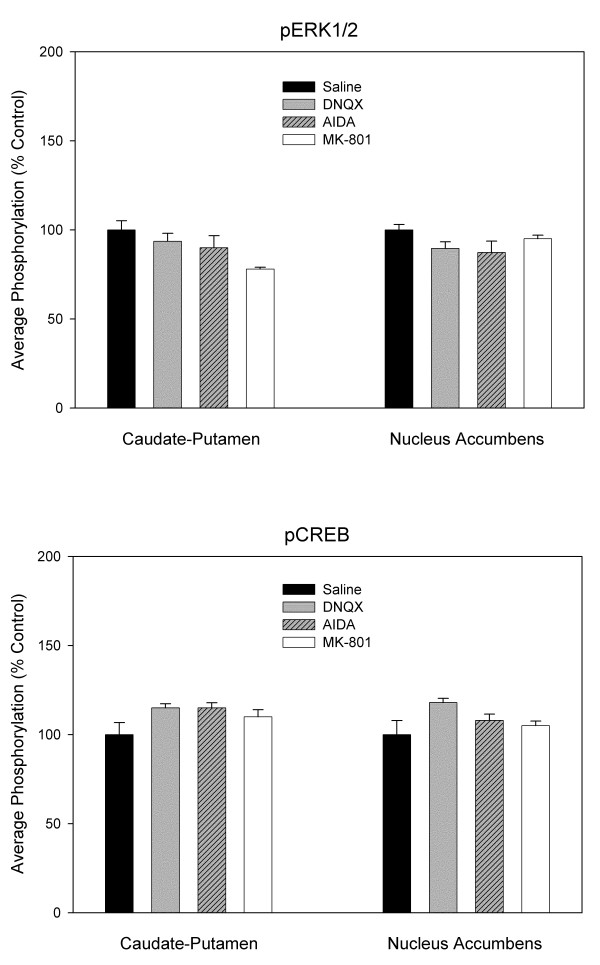
Effects of Glutamate Receptor Antagonists on Activation of ERK1/2 and CREB in Caudate-Putamen and Nucleus Accumbens of Food-Restricted Rats Food-restricted rats received i.c.v. injections of either saline vehicle, the AMPA antagonist DNQX (10 nmol), the group I mGluR antagonist AIDA (100 nmol), or NMDA antagonist MK-801 (100 nmol) prior to sacrifice. Lysates were immunoblotted with anti-phospho ERK1/2 or anti-ERK1/2 (top) and anti-phospho-CREB or anti-CREB (bottom) Following densitometry, intensities of bands corresponding to phosphorylated proteins were divided by intensities of the corresponding total protein bands to correct for small differences in protein loading. Results (mean ± S.E.M.) for caudate-putamen (left in each figure) and nucleus accumbens (right in each figure) are expressed in comparison to the normalized control, which was defined as the group injected with saline vehicle.